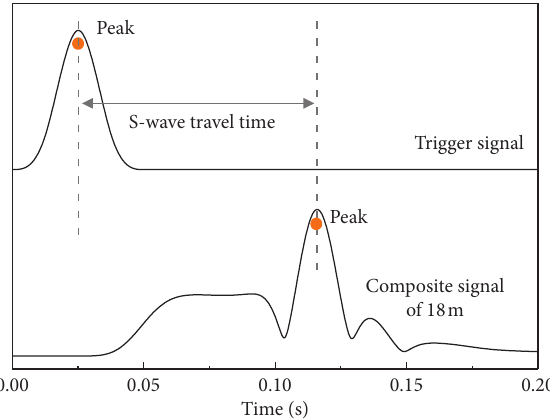
Figure 4: Schematic of NPPM for S-wave travel time